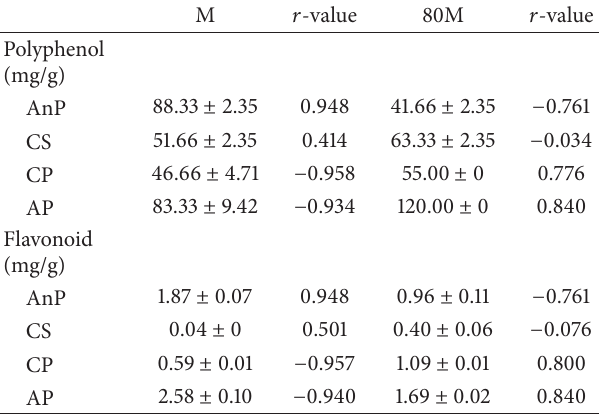
Table 2: Correlation between the antioxidant activity of plant extracts against oxidation of LDL and the content of polyphenol and flavonoid in the extracts.